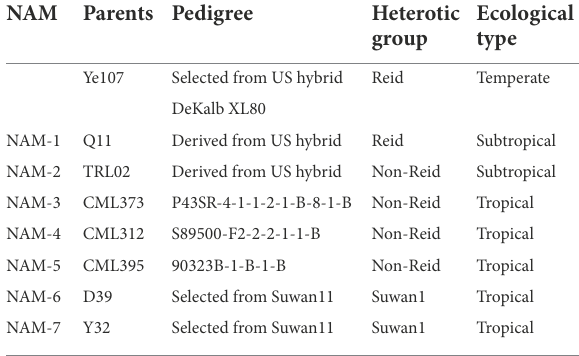
TABLE 1 Information on the common parent (Ye107) and seven lines that were crossed to it for developing seven nested-association mapping